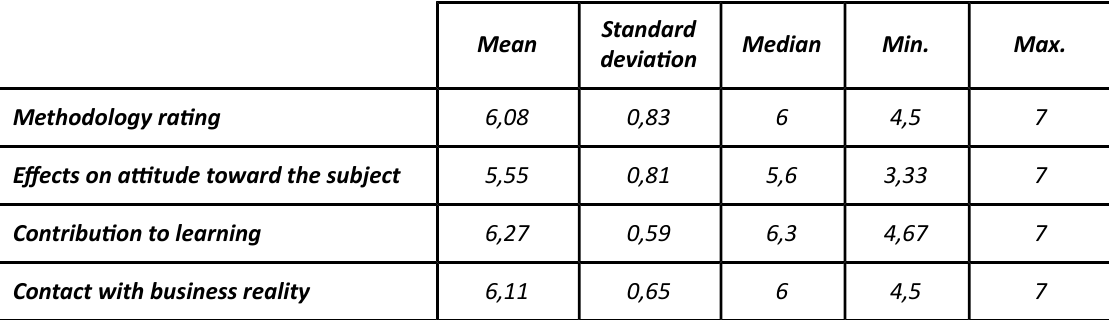
Table 5. Descriptve